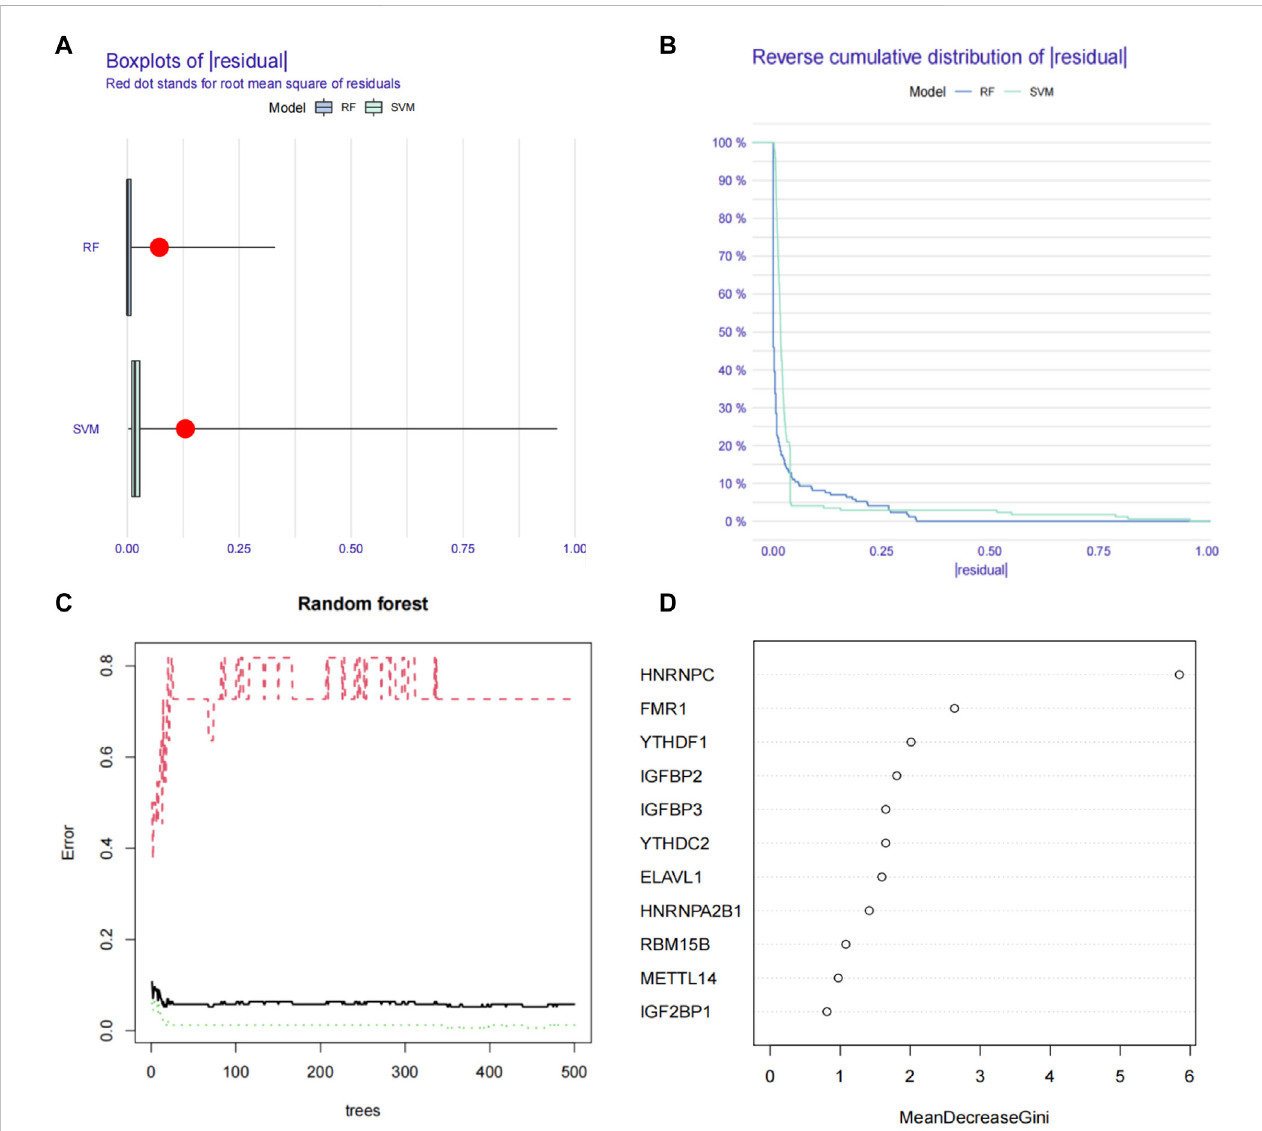
FIGURE 3 Using machine learning to fi nd ESCC-related m6A regulators in TCGA-ESCA database. (A) Boxplots of residual values of RF (Random Forest) and SVM (Support Vector Machine) models. Red dot represents the mean residual value. (B) Cumulative residual distribution plots of RF (Random Forest) and SVM (Support Vector Machine) models. (C) The error value of therandom forest. The red line represents theerror of the ESCC group, the green line represents the error of the Normal group, and the black line represents the total sample error. The minimum error point of the three-group cross-validation is is 0.076, corresponding to 18 optimal random forest trees. (D) Mean Decrease Gini score of 11 differentially expressed m6A regulators extracted from TCGA-ESCA database. RF, Random Forest; SVM; Support Vector Machine; m6A, N6-methyladenosine; TCGA, The Cancer Genome